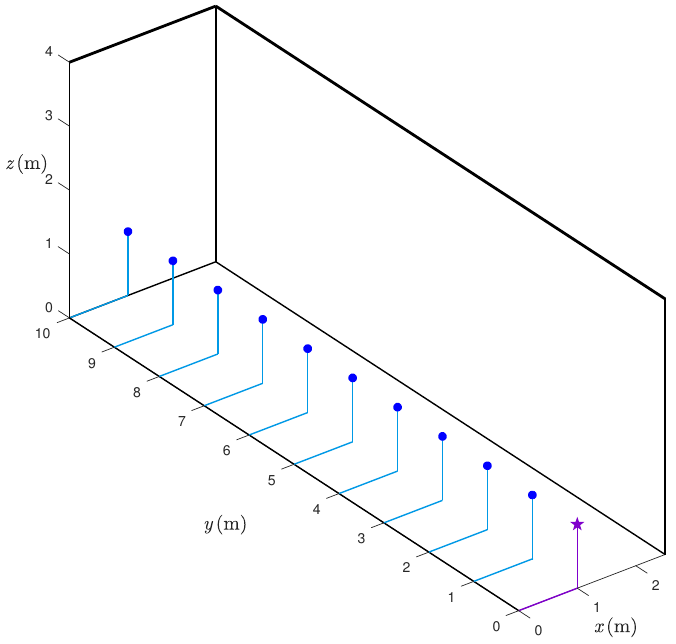
Figure 2. Scenario of the experimental setup: the position of the requester (purple star) and the 10 positions of the responder (blue dots) are